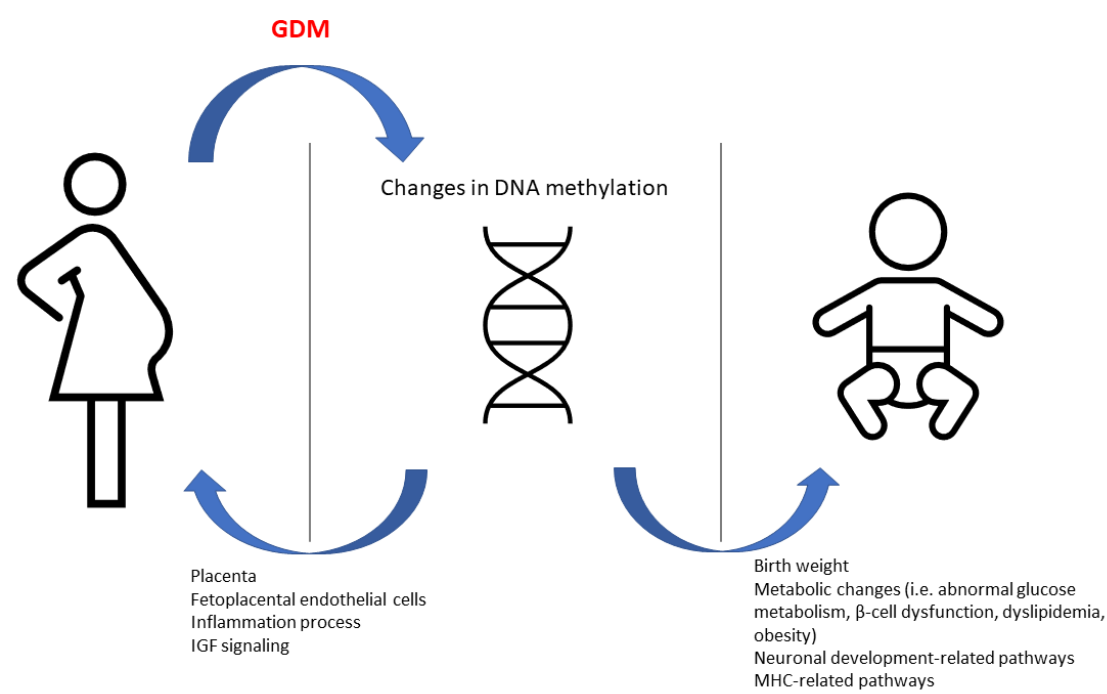
Figure 1. The effect of changes in DNA methylation in GDM women and their offspring.